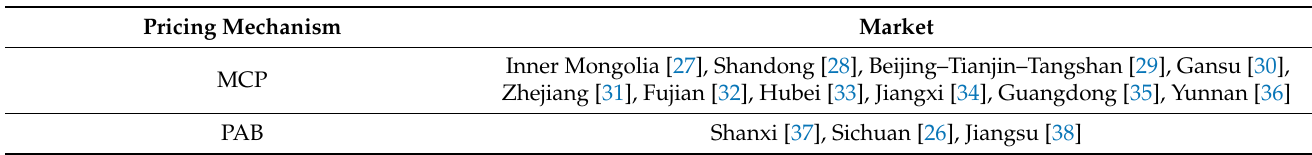
Table 1. Pricing mechanisms used in the frequency regulation ancillary services market in various provinces and regions in